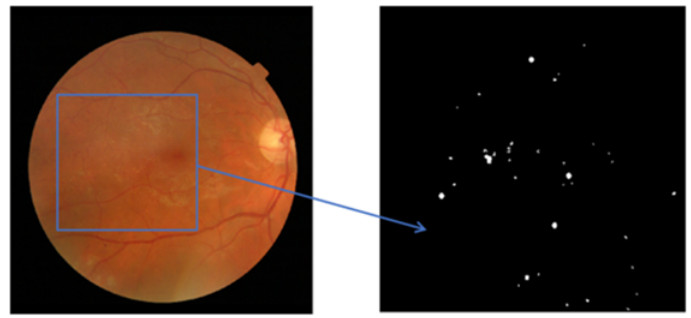
Figure 4. The input retinal fundus image and the background retinal fundus image. In the right side background image, an optimal form of discrimination can be found.